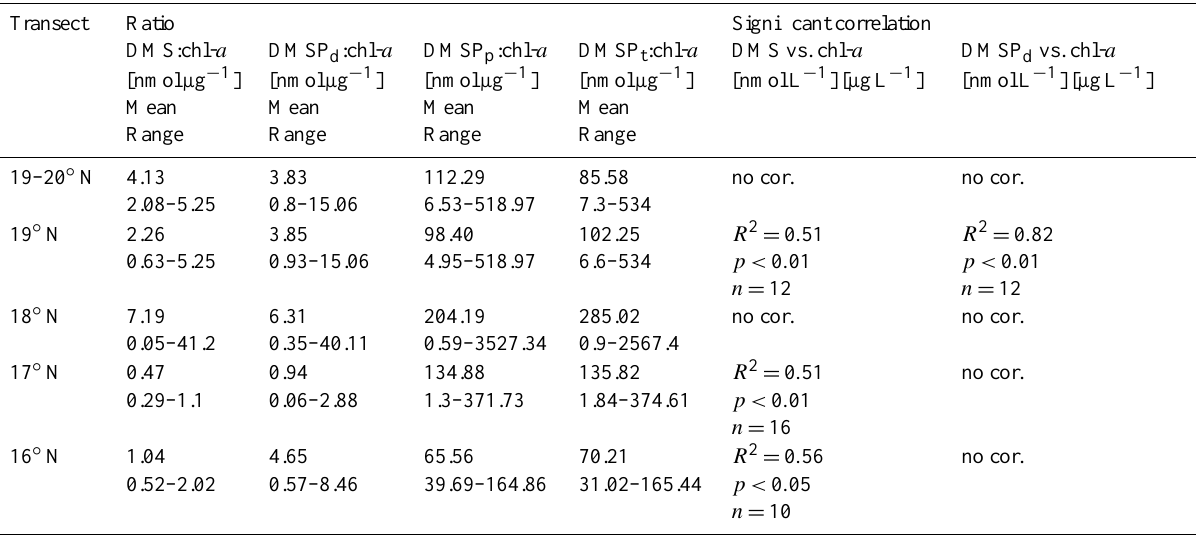
Table 2. Ratios and correlations of DMS, DMSP with chlorophyll- a for different transects in the Mauritanian upwelling region. No correlation could be found for DMSP p and chlorophyll- a